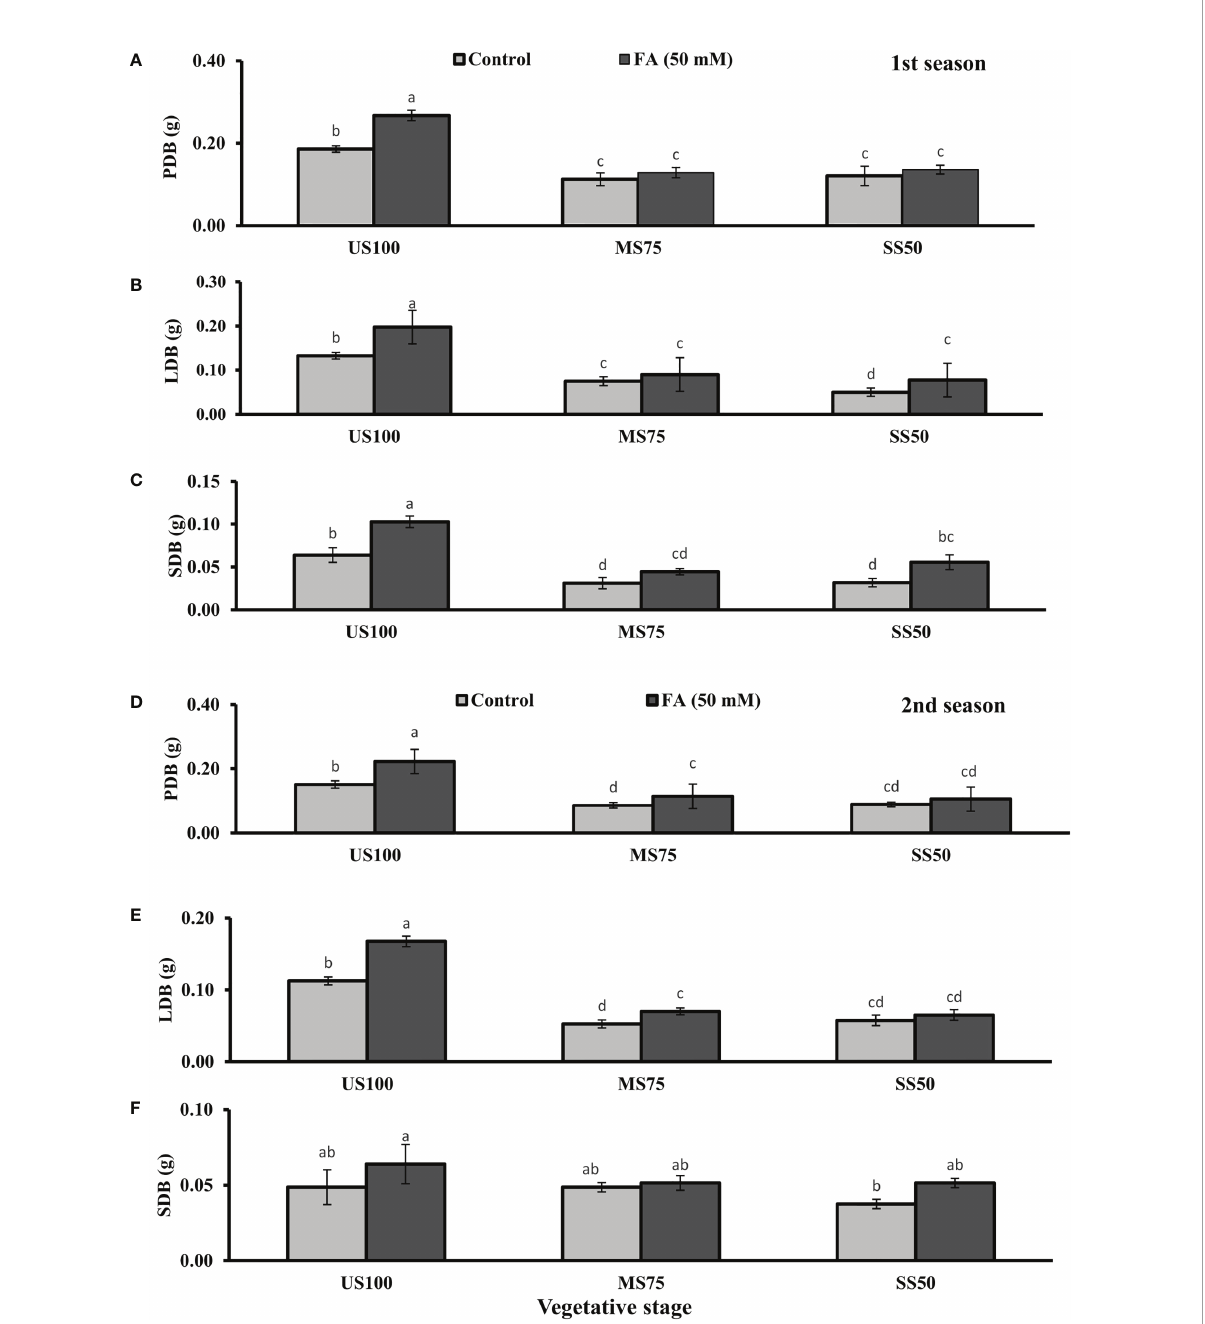
FIGURE 2 Effect of foliar application of folic acid (50 mM) at the vegetative stage on (A, D) plant dry biomass/plant, (B, E) leaf dry biomass/plant, and (C, F) shoot dry biomass/plant in the fi rst and second seasons. The graph values are the mean ± SE of four replicates. The bars exhibited with different letters indicate a signi fi cant difference between samples by least signi fi cant difference ( p ≤